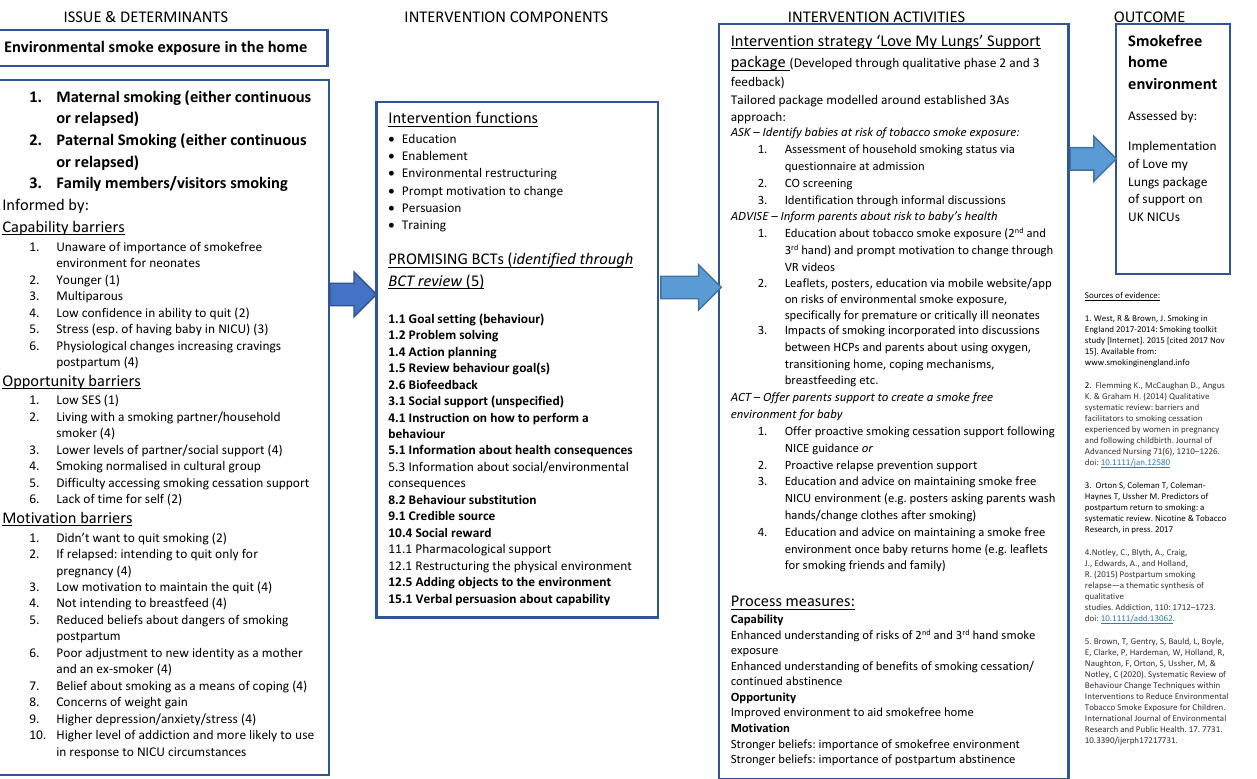
Figure 1: Neonatal Unit Smoking Cessation intervention (‘Love my Lungs’): Logic model